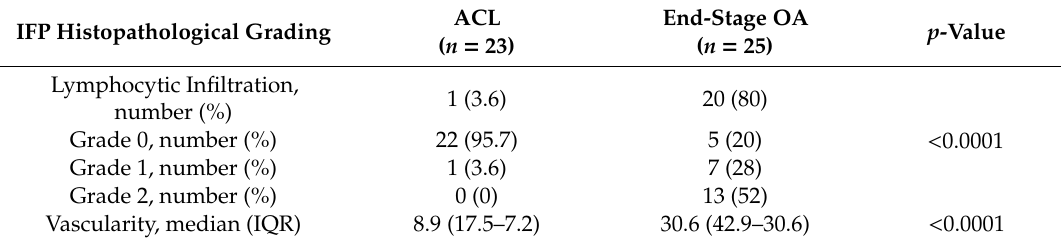
Table 1. Infrapatellar fat pad histopathological scoring system.